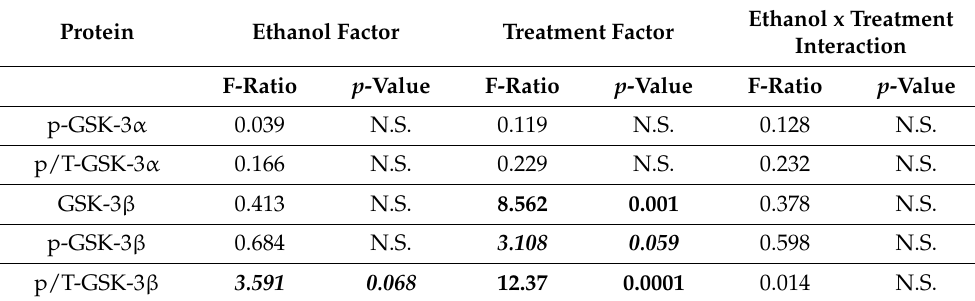
Immunoreactivity was measured with 11-Plex Akt/mTOR total protein and phosphoprotein magnetic bead- based assays. The table lists the two-way ANOVA test results (F-Ratios and p -Values) for ethanol, treatment (Chol or D+G), and ethanol x treatment interactive effects on Akt, PTEN, GSK-3 α , GSK-3 β , pS473 -Akt, pS380 - PTEN, pS21 -GSK-3 α , and pS9 -GSK-3 β , and the calculated relative phosphorylation (p/T) levels of each protein. DF for all tests: interaction DFn, DFd (2, 30); treatment DFn, DFd (2, 30); exposure DFn, DFd (1, 30). The bold (non-italicized) font highlights significant results. Bold italics highlight statistical trends. Abbreviations: R = receptor; p = phosphorylated; N.S. = not statistically significant. N = 6 rats/group with 3 replicate cultures per rat.